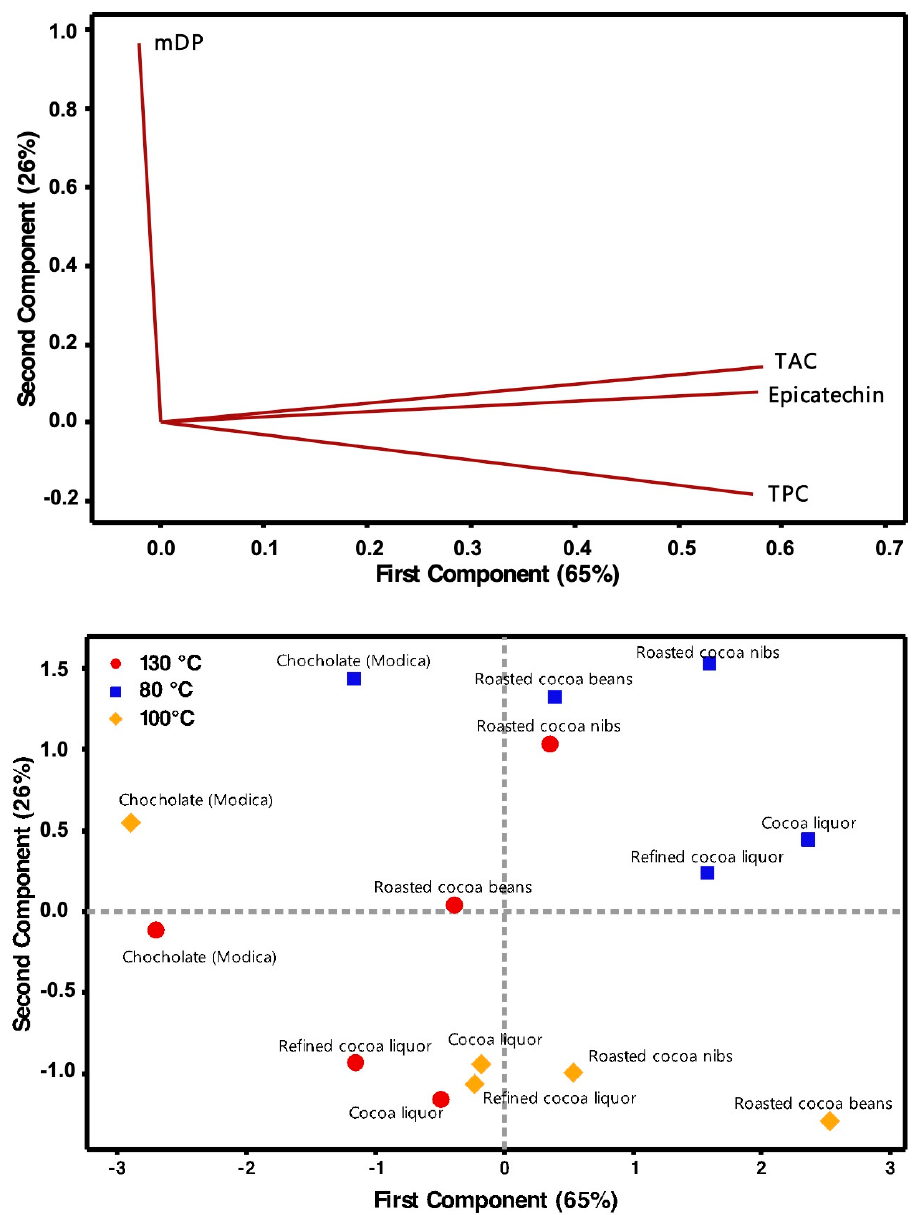
Figure 8. Loading plot ( upper ) and score plot ( lower ) representing the bidimensional space of PC1 and PC2 derived by PCA.